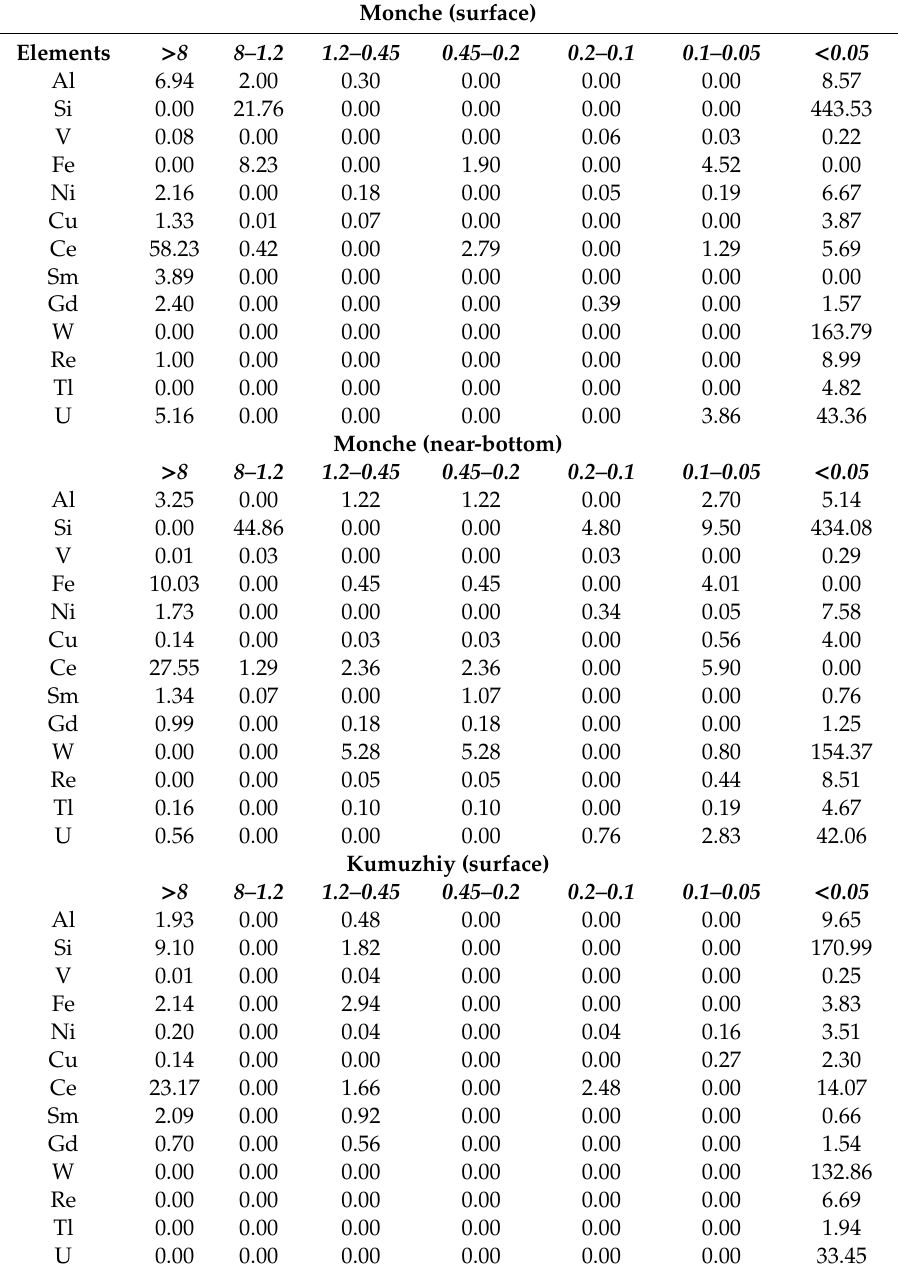
Table 2. The content of some elements in the filtrates during sequential membrane filtration (taking into account the volume of an aliquot): Al-Cu µ g / L, other elements–ng /